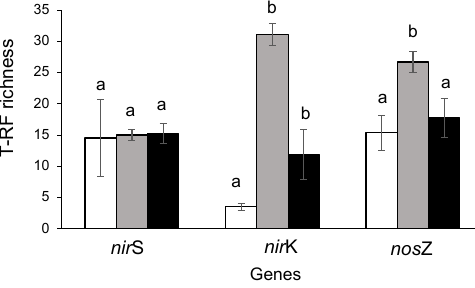
Figure 2. T-RF richness by soil group. White, grey, and black bars denote groups 1, 2, and 3 soils. Mean values are reported ± 1SE (standard error) of the mean. Means with the same letters do not differ significantly at α =